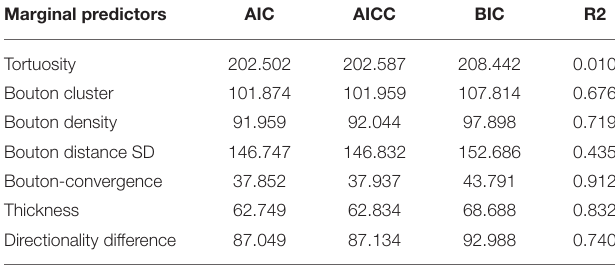
TABLE 9 | Model fit statistics for the seven